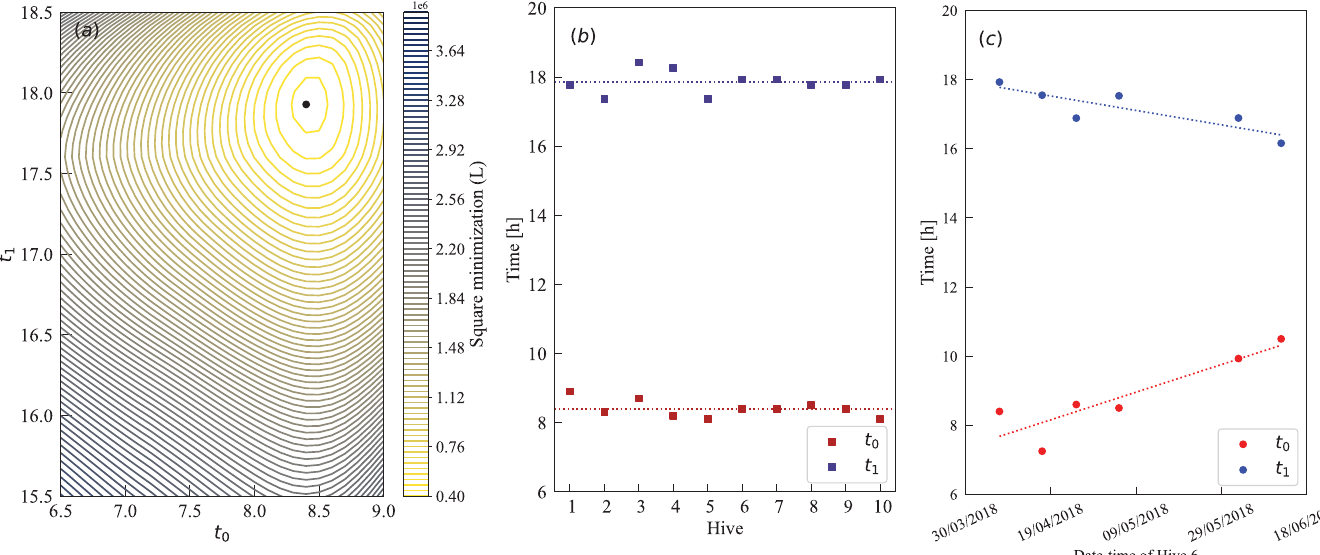
Fig 5. Inference of activity times t 0 and t 1 . (a) Contour plot of L obtained performing multiple minimizations at fixed t 0 and t 1 (‘Hive 6’ at 2018–4-7). The minimum L is at t 0 = 8.40 h and t 1 = 17.93 h. (b) Estimated t 0 and t 1 fluctuate around similar values for ten different hives located in close proximity when analysing data sets during the same day. E.g. at 2018–4-7, the different activity times oscillate around t 0 = 8.4 h and t 1 = 17.85 h, respectively (dashed lines). (c) Time evolution for the optimum t 0 and t 1 for ‘Hive 6’ only. Transitioning from Autumn to Winter, we observe a linear increase for t 0 and a linear decrease for t 1 (linear regression).